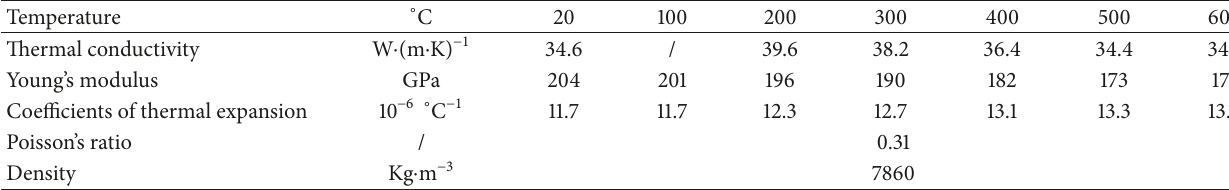
Table 1: Material properties of the gas turbine rotor (compressor discs).